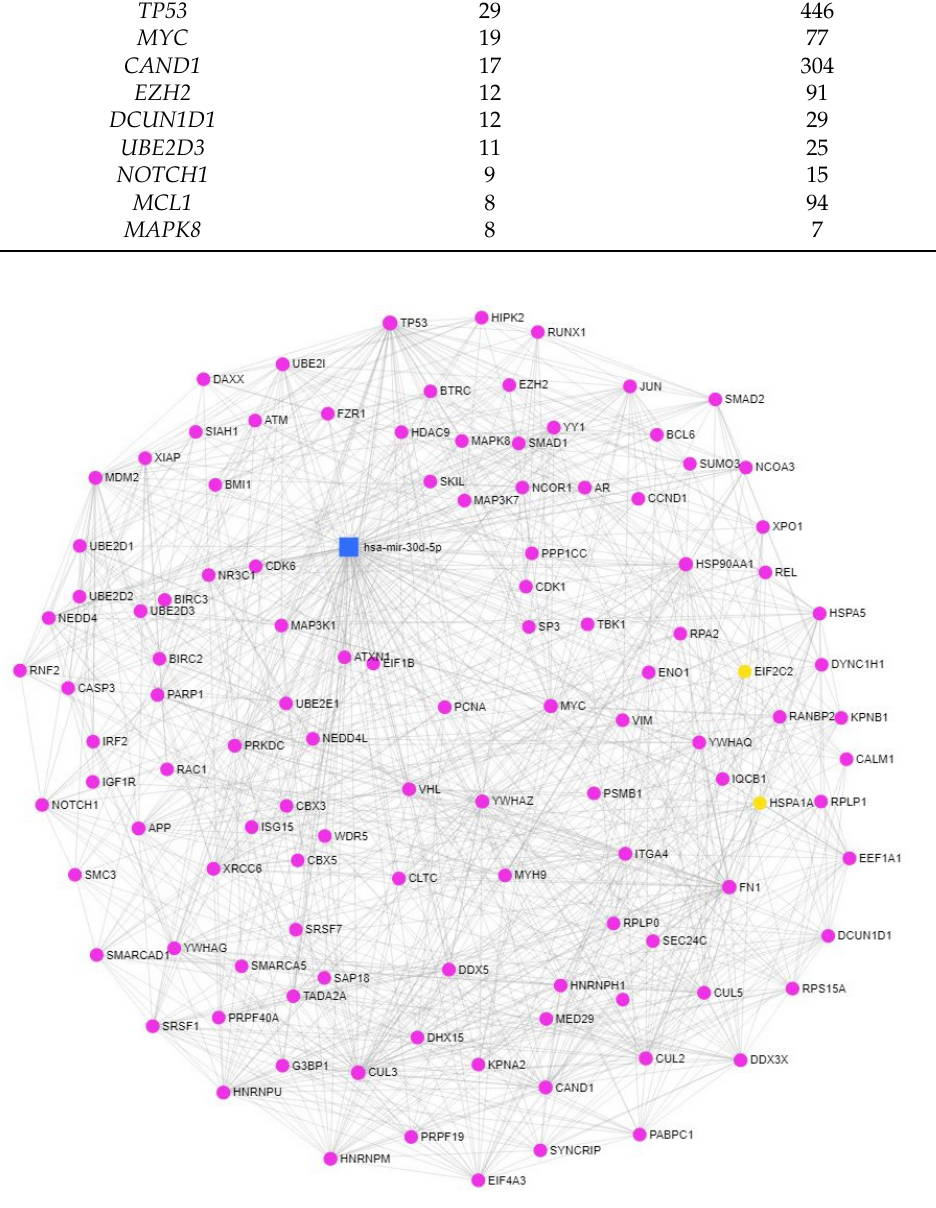
Figure 4. Functional annotation analysis of the targets of miR-30d-5p. Gene–gene and protein–protein interactions of the targets of miR-30d-5p were generated by the miRNet tool.